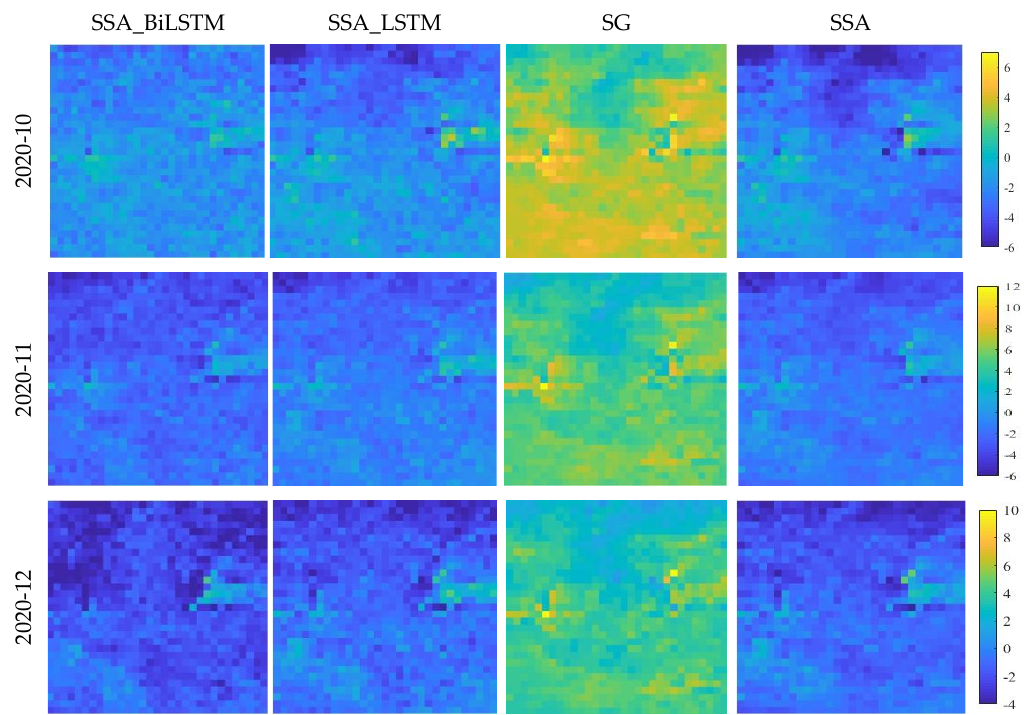
Figure 9. Comparison of images reconstructed using the proposed method and other LST reconstruction methods.